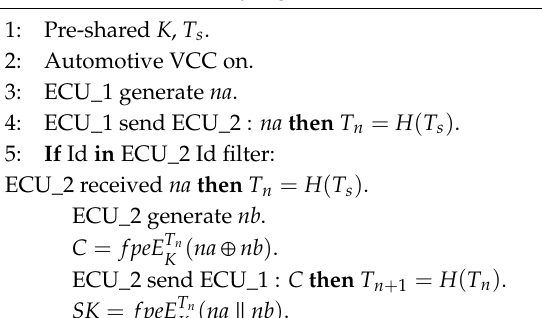
Algorithm 1 Session Key Agreement.